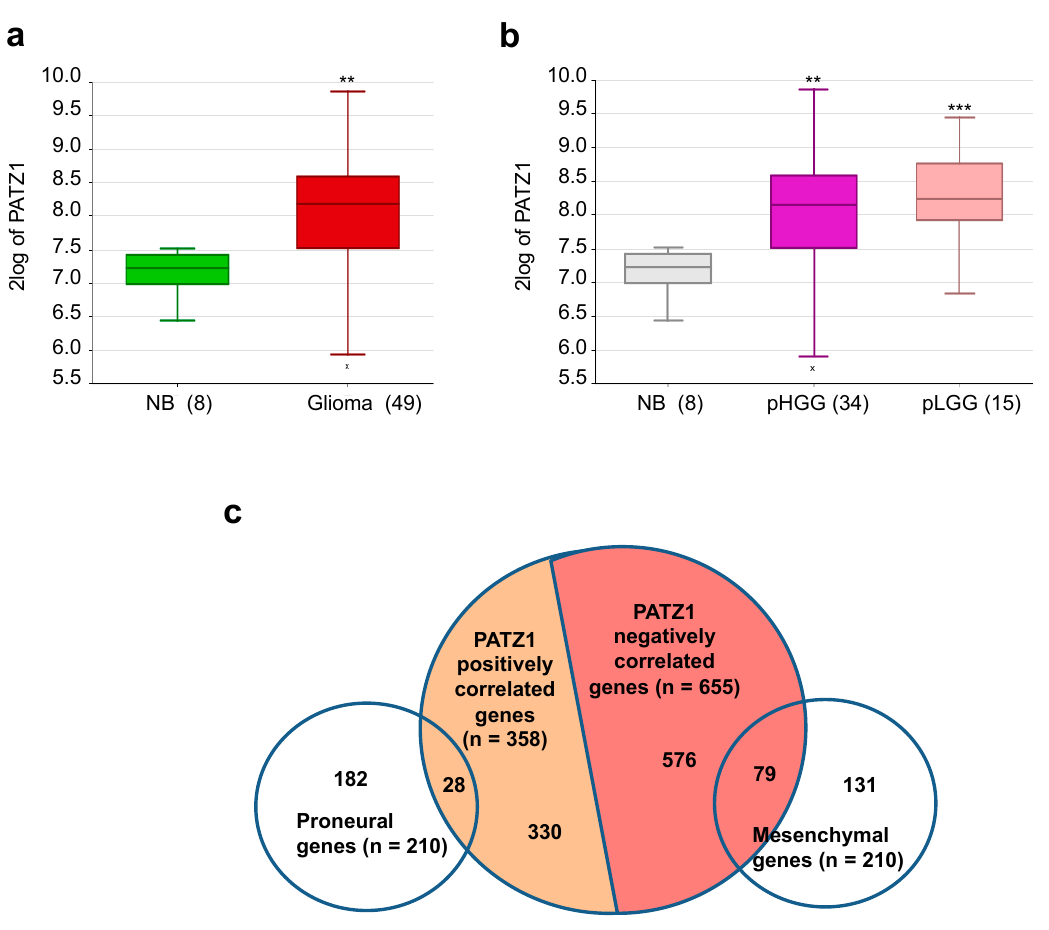
Figure 1. In silico analysis of PATZ1 expression in pediatric glioma tissues. ( a ) Box plot comparing PATZ1 expression in normal brain (NB) and pediatric gliomas, including both low- (pLGG) and high-grade (pHGG) tumors (GSE50161). The data were analyzed by one-way analysis of variance (ANOVA) through the R2 web platform. The number of tissues is indicated in brackets. ** p < 0.01 versus NB. ( b ) Box plot showing PATZ1 expression in the two different subtypes compared with normal control. No differences were observed between pLGG and pHGG. The number of tissues is indicated in brackets. ** p < 0.01; *** p < 0.001 versus NB. ( c ) Schematic representation of the overlapping between PATZ1-correlated genes in pediatric gliomas and either proneural or mesenchymal genes of the adult glioblastoma signatures described by Verhaak et al. [23].